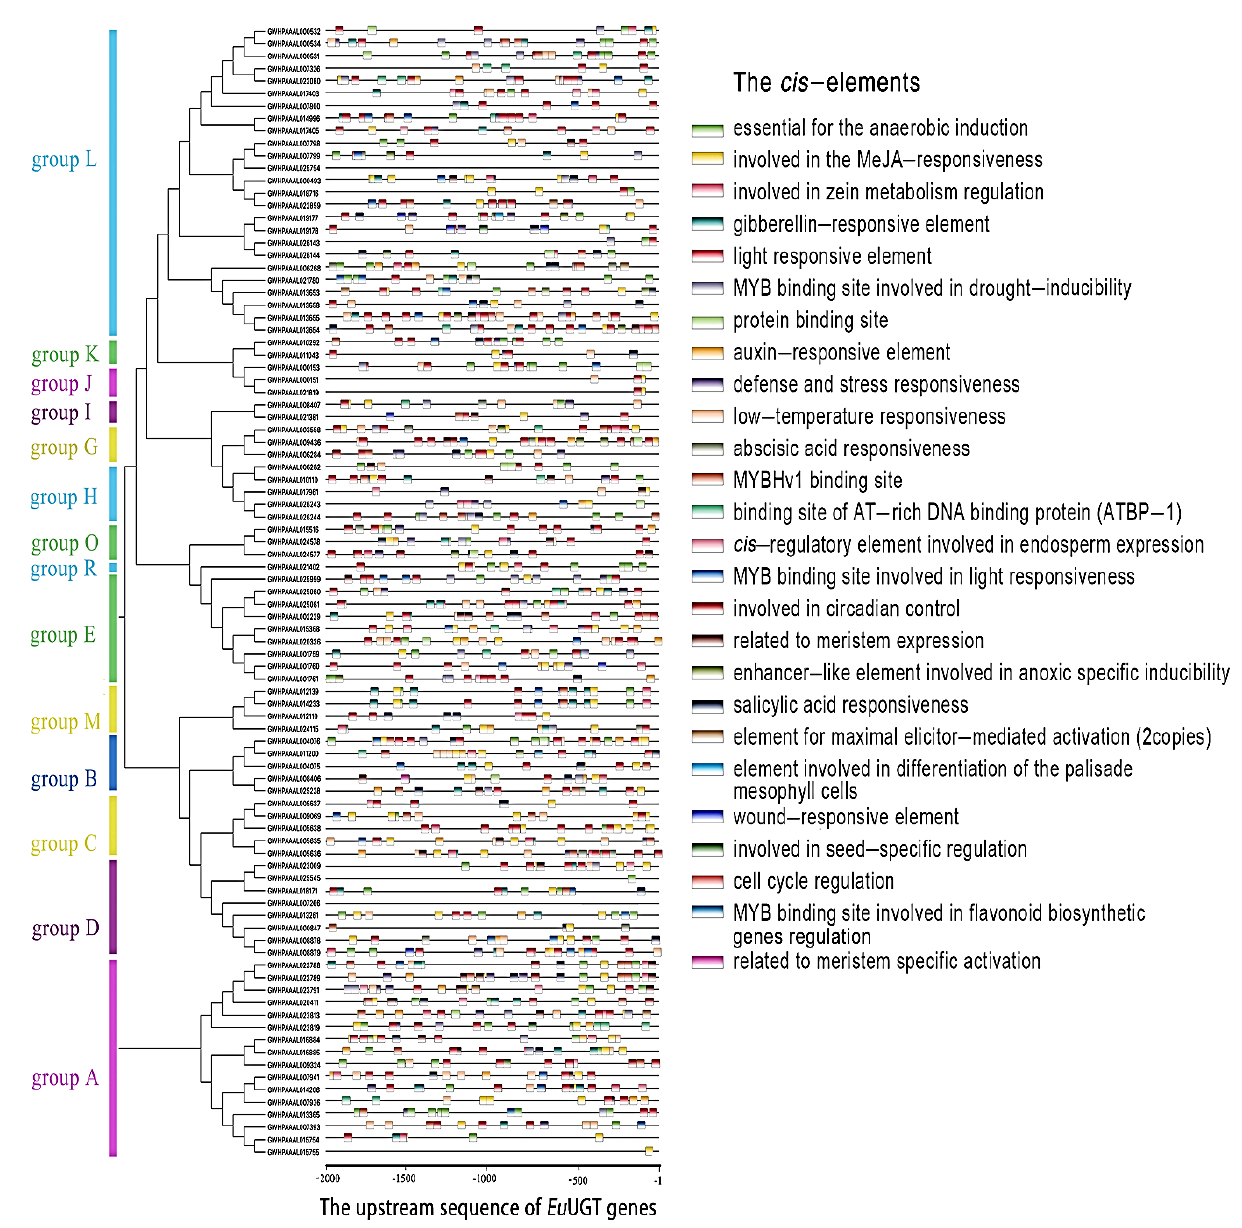
Figure 4. The predicated cis -acting elements localized within the 2000-bp upstream of Eu UGT genes.